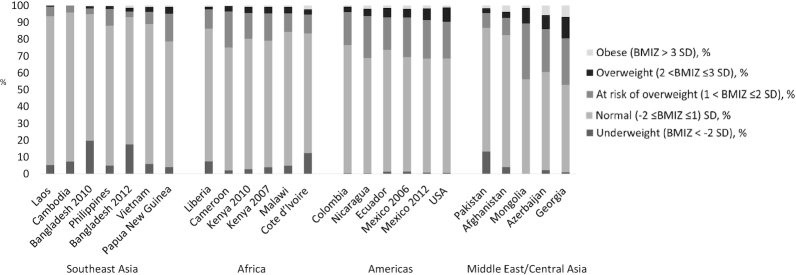
Distribution of BAZ among preschool children, by survey, Biomarkers Reflecting Inflammation and Nutritional Determinants of Anemia project. Shaded bars indicate the proportion of children in each survey categorized as underweight (BAZ < −2 SD), normal weight (−2 ≤ BAZ ≤ 1), at risk of overweight (1 < BAZ ≤ 2 SD), overweight (2 < BAZ ≤ 3 SD), and obese (BAZ > 3 SD). BAZ, BMI-for-age z score.